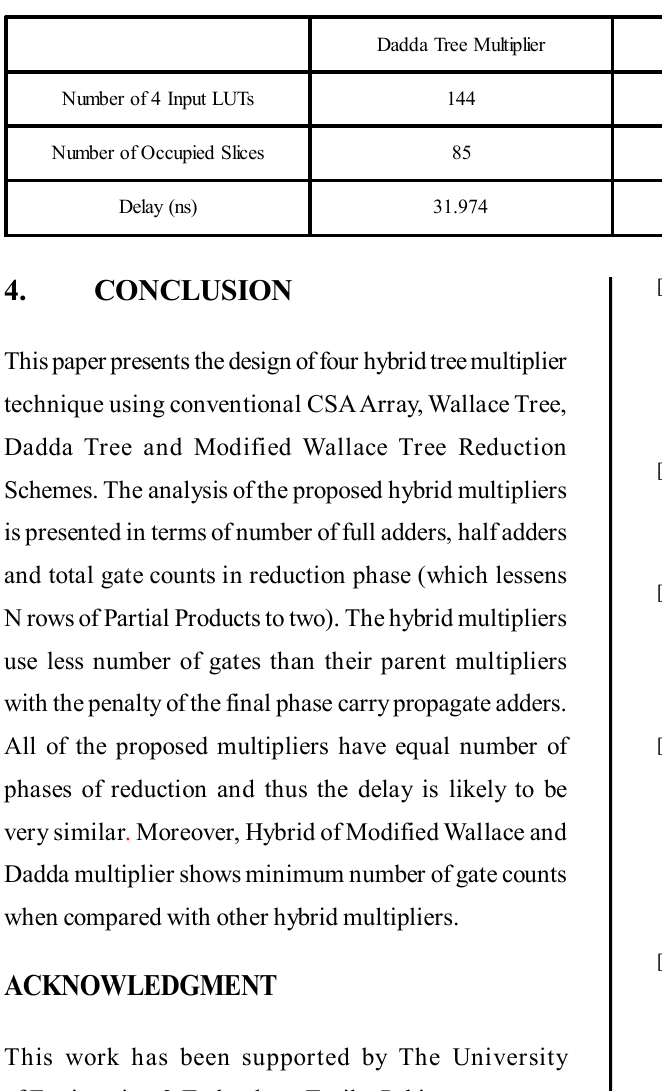
Design and Analysis of Hybrid Tree Multipliers for Reduction of Partial Products TABLE 3. SYNTHESIS